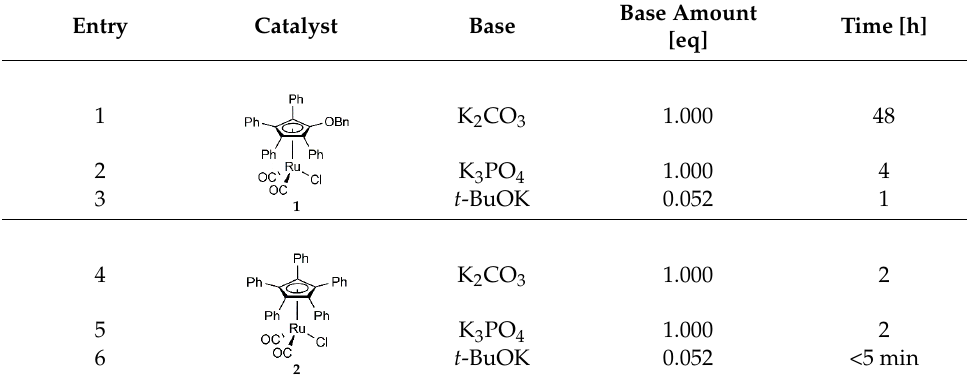
Figure 2. Effect of the acyl donor on the performance of CALB-MCF-3.0Me catalyst ( A ) and Novo- zym 435 ( B ) in the transesterification of ( rac )-1-phenylethanol. Entry